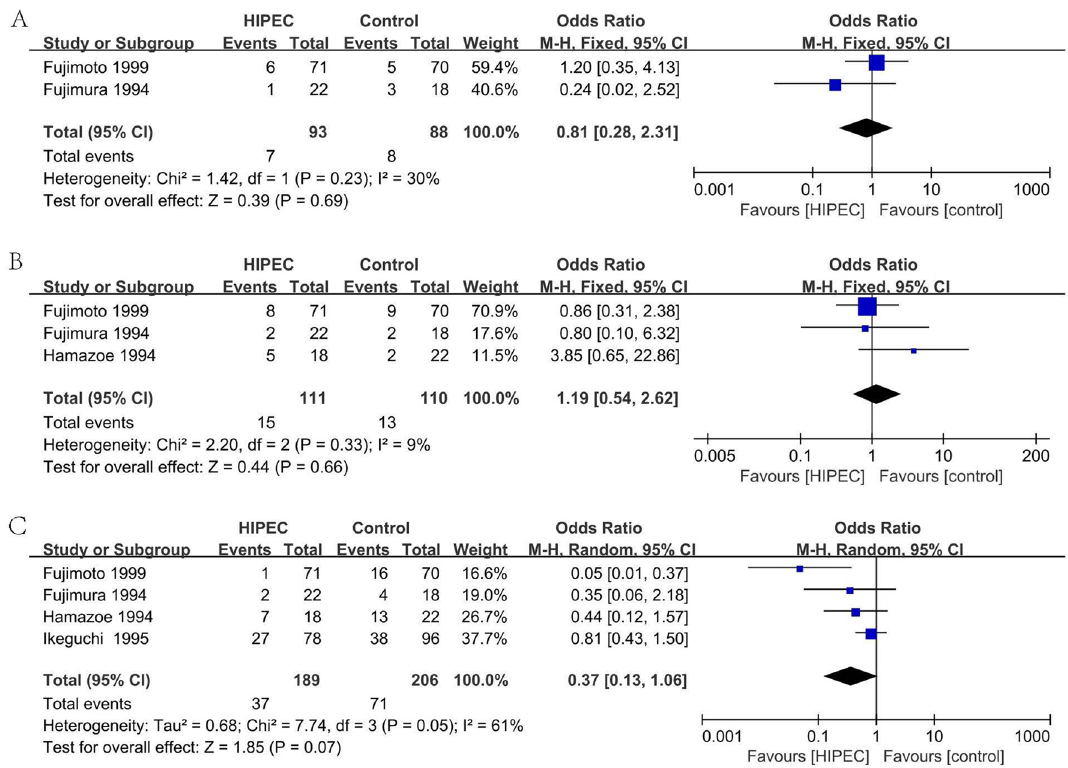
Figure 11. Death due to recurrence after surgery: liver recurrence ( A ), Death due to recurrence after surgery: lymph node and local recurrence ( B ), Death due to recurrence after surgery: peritoneum recurrence ( C